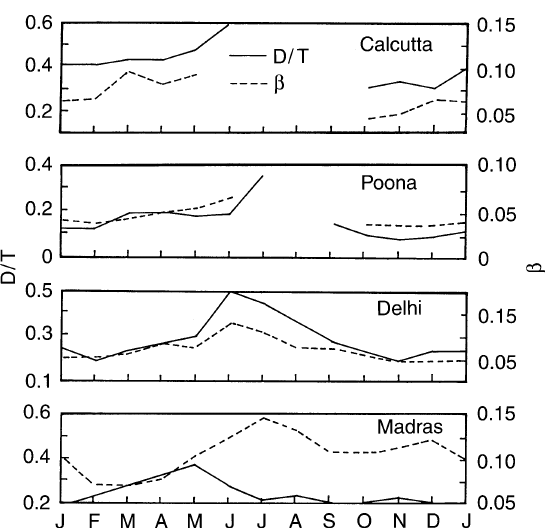
Fig. 4. The monthly variations of diffuse to global solar radiation ( D / „ ) and Angstrom turbidity coefficient ( (cid:98) ) for the four Indian stations